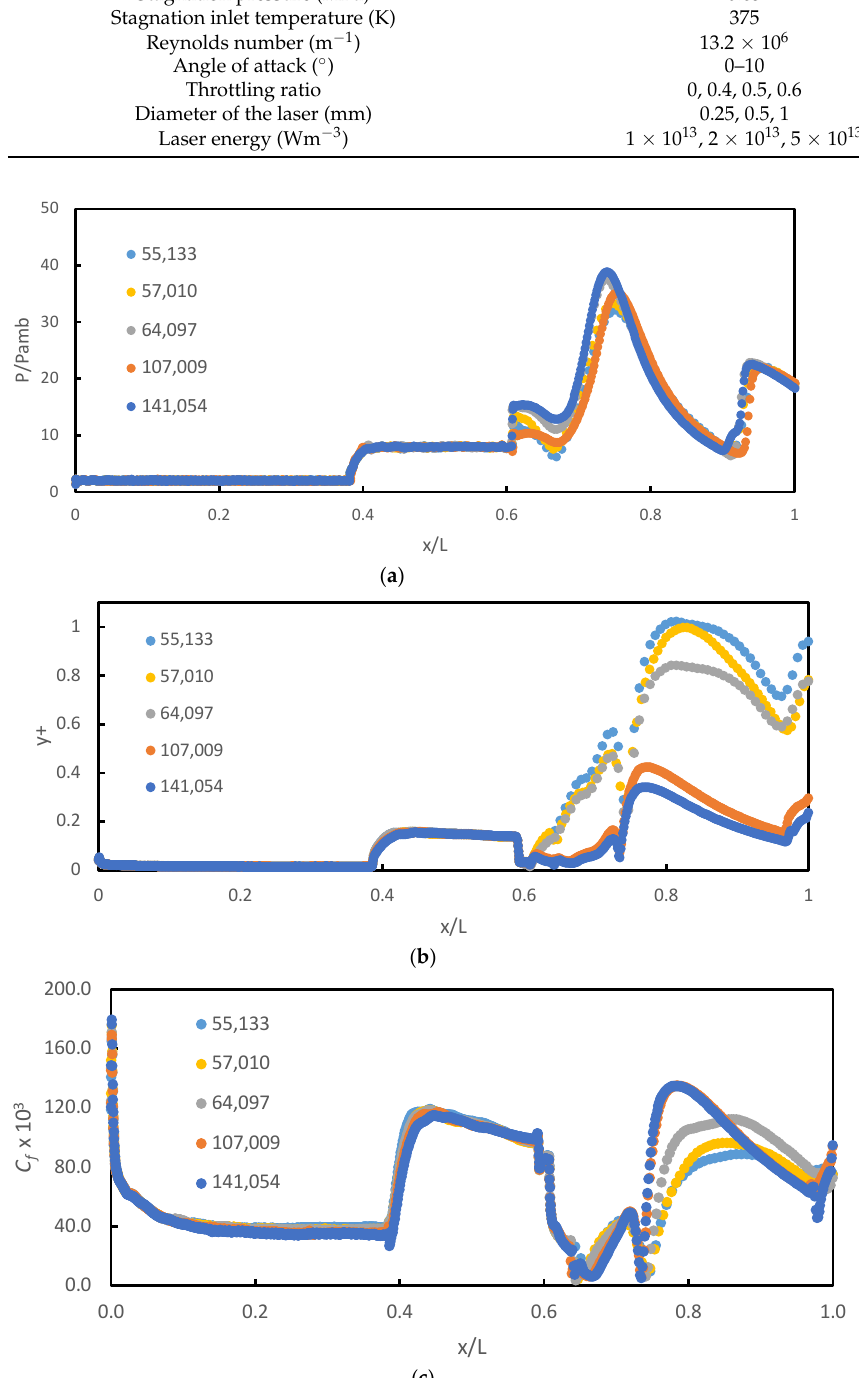
Figure 2. Mesh independence study of ( a ) pressure ratio, ( b ) y+, and ( c ) skin friction coefficient, C f .